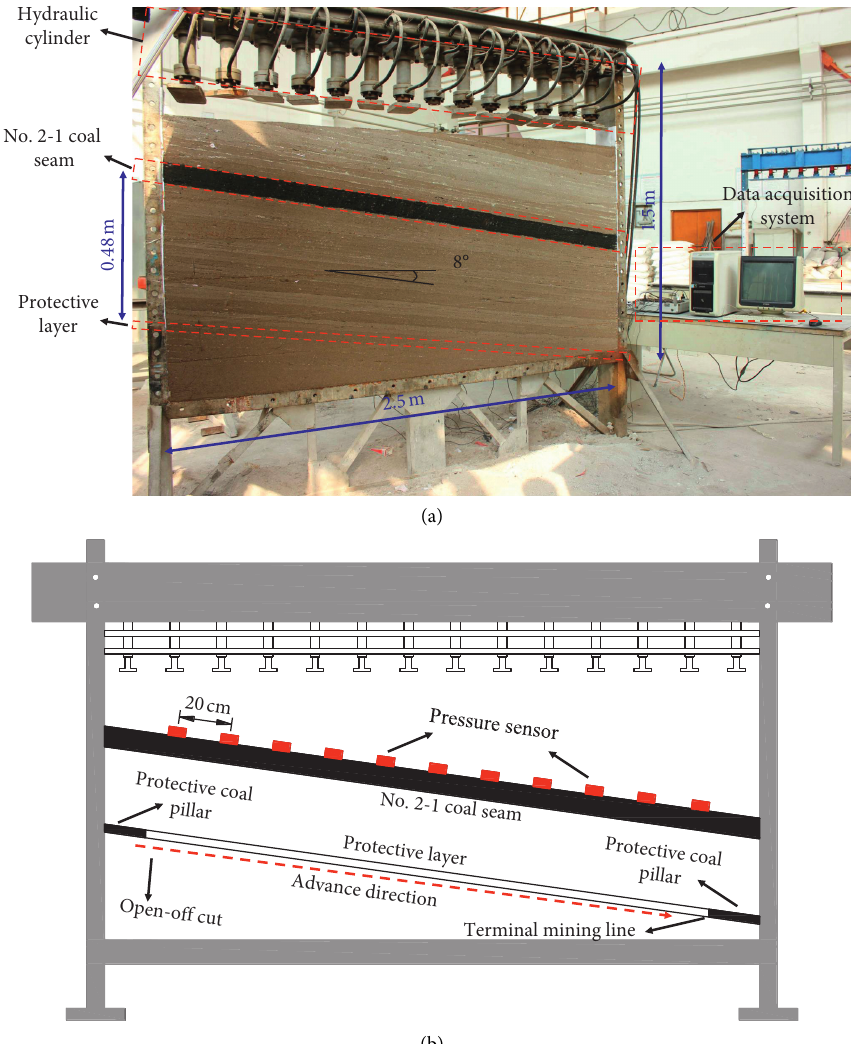
Figure 9: Experimental model device and scheme. (a) Model device; (b) model scheme.